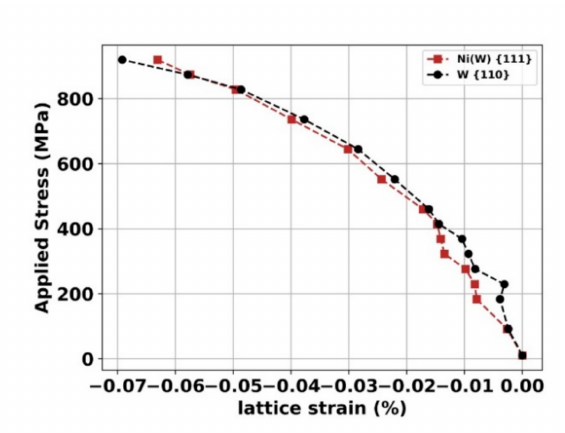
Figure 4. Applied stress as a function of the lattice strain of the Ni(W) {111} and W {110} orientations of the Ni-50W alloy.